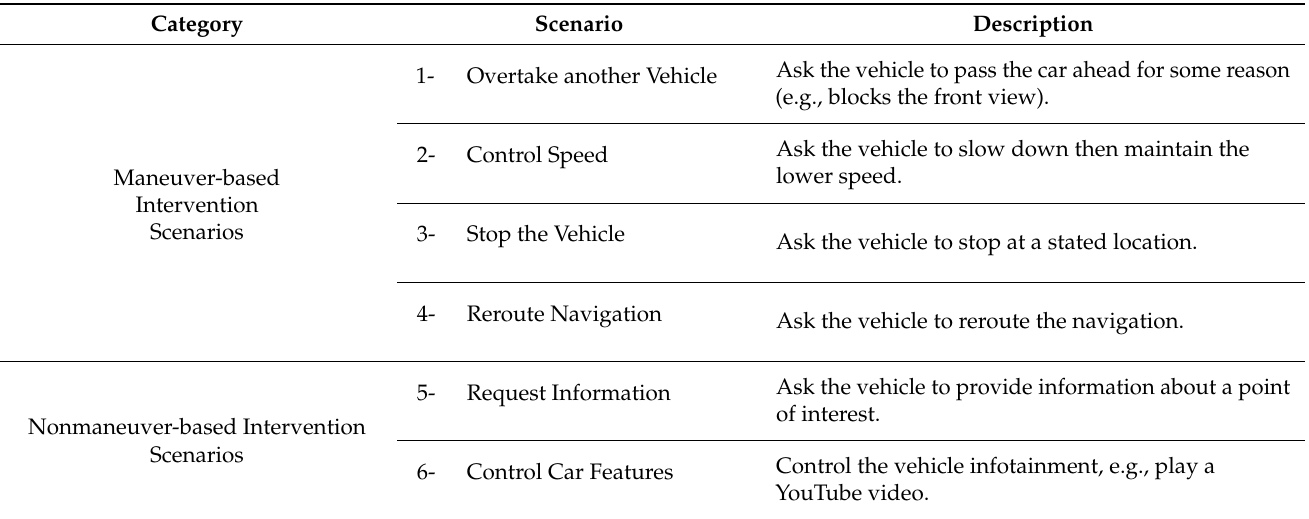
Table 2. Description of the driver intervention